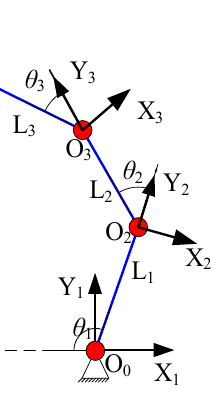
Figure 6. Establishment of the coordinate systems for the simplified finger.